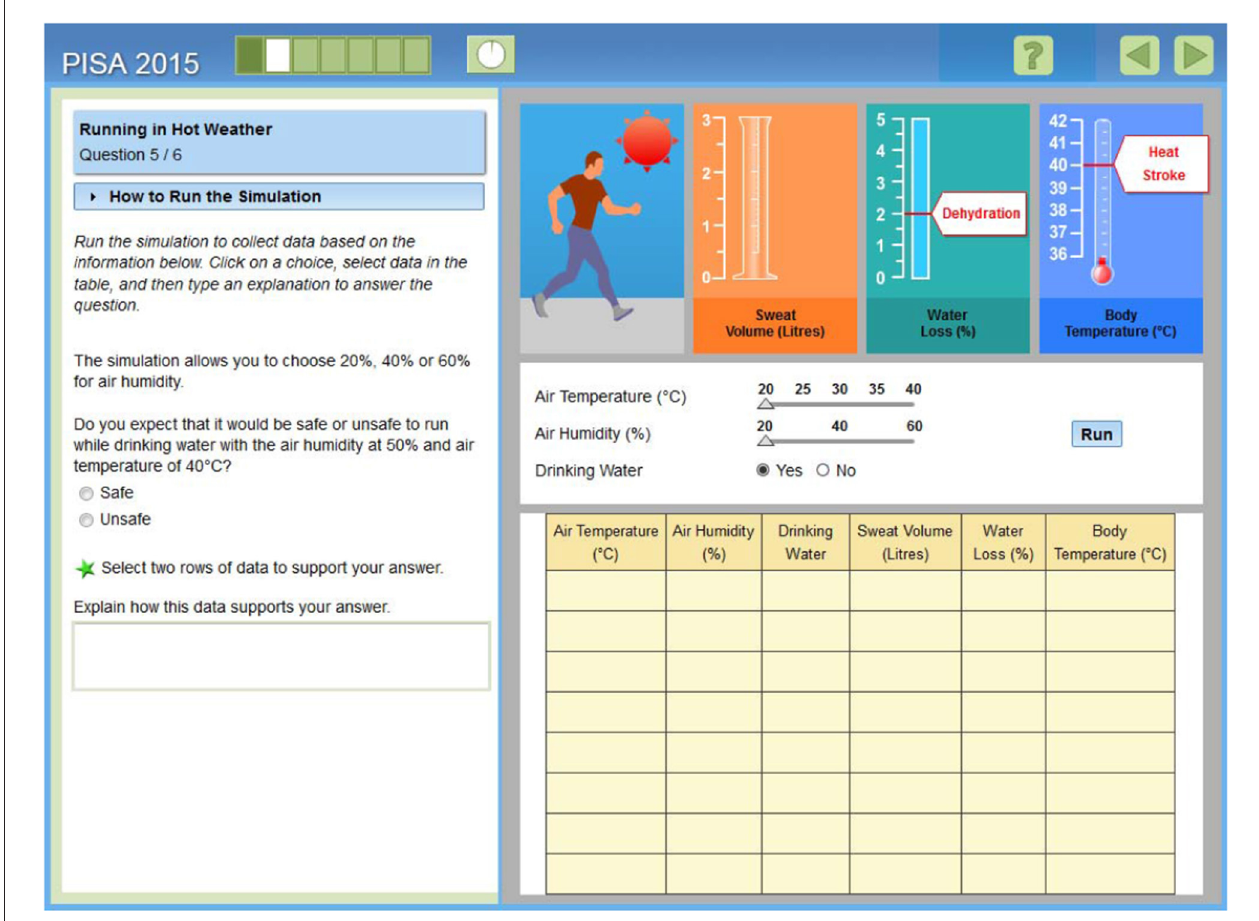
FIGURE 1 | Screenshot of the PISA (Programme for International Student Assessment) field trial item, Running in Hot Weather . Multivariable reasoning is required to solve the item ( OECD, 2013, p.